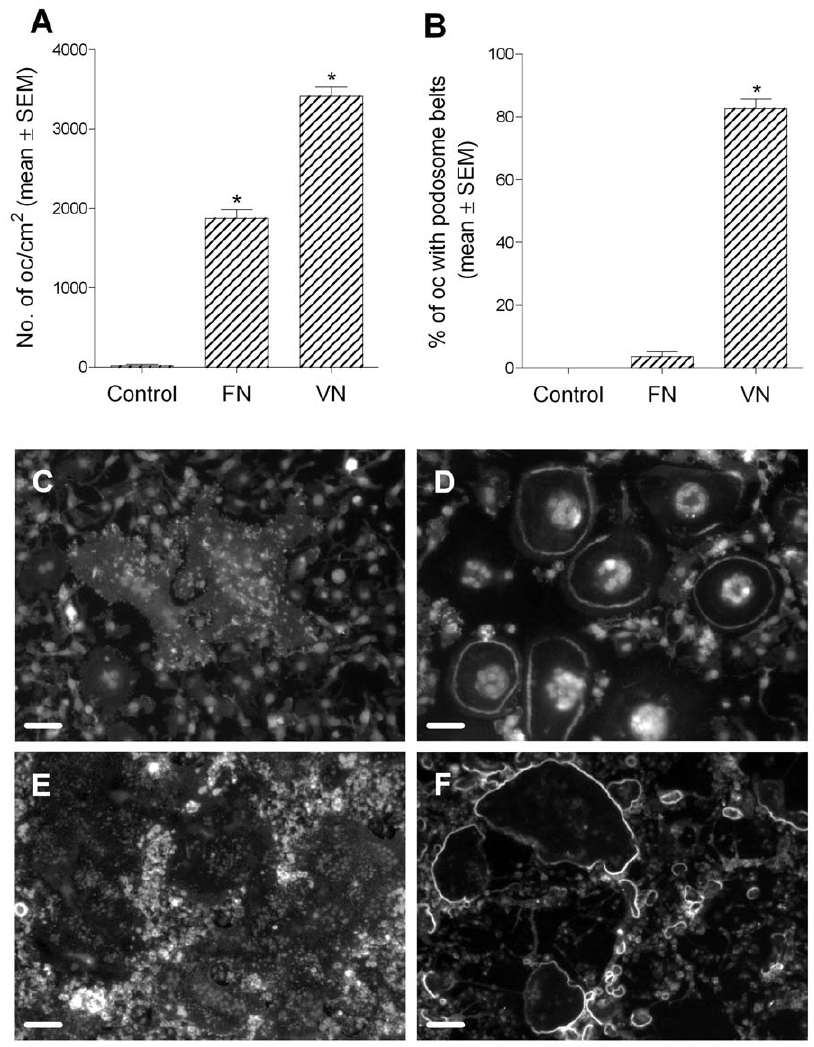
Figure 9. Flexible substrates can induce podosome belt formation. Osteoclasts were incubated for 5 hours in MEM/BSA with M-CSF (50 ng/ ml), RANKL (30 ng/ml) and IL-1 a (10 ng/ml) on PDMS sheets or silicone films coated with vitronectin or fibronectin (50 m g/ml). A,B: Osteoclasts adhered to fibronectin-coated PDMS sheets in large numbers, but podosome belts were very rare. In contrast, a similar proportion of osteoclasts formed podosome belts on vitronectin-coated PDMS sheets to our previous experience using rigid substrates. *p , 0.05 versus control (ANOVA + Dunnett’s); n=10 per group. C–F: Representative views of osteoclasts on fibronectin-coated silicone film (C) or PDMS sheet (E)0; and vitronectin- coated silicone film (D) or PDMS sheet (F). Note that osteoclasts on fibronectin-coated substrates are well-spread but lack podosome belts. Phalloidin/ DAPI staining. Scale bars: C,D: 50 m m; E,F: 100 m m.